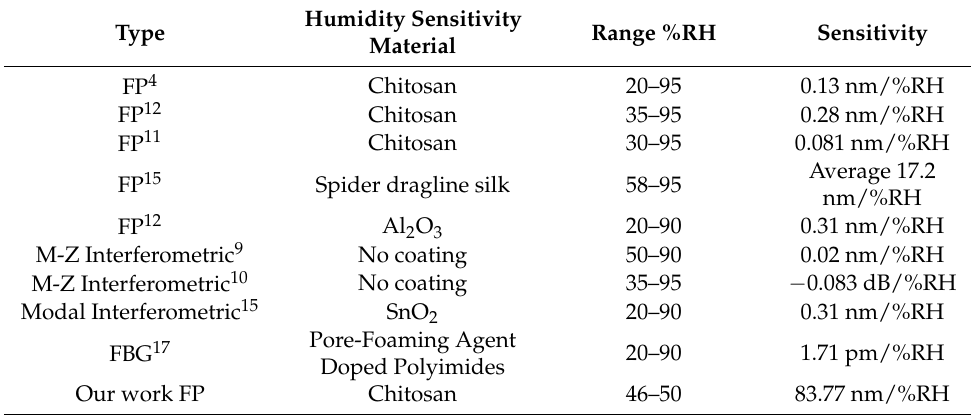
Table 1. Performance comparison of the proposed sensor and other optical fiber-based humidity sensors reported in